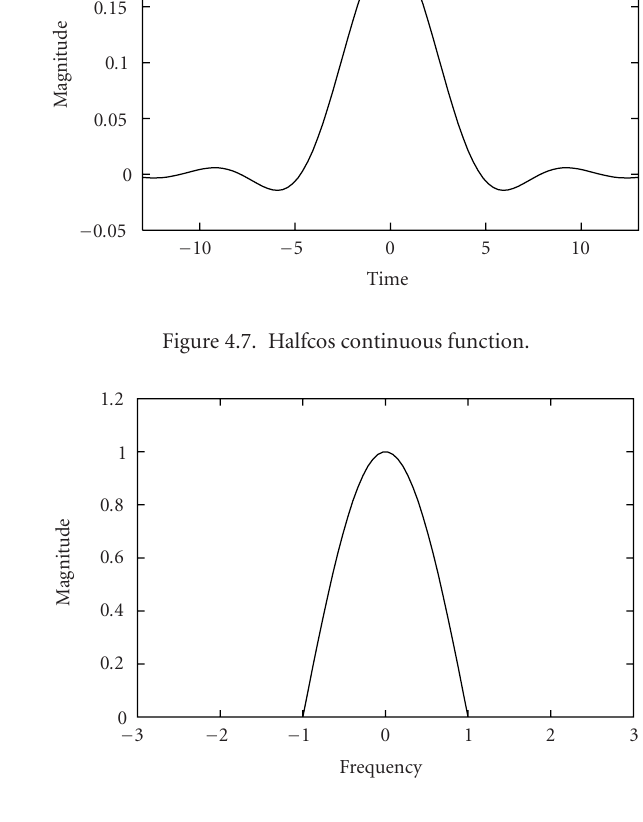
Figure 4.8. Halfcos